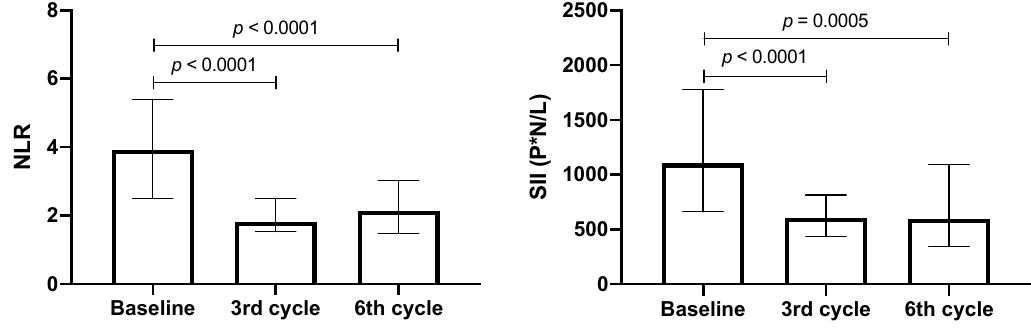
Figure 3. Concentration of IL-6, TGF- β , and HMGB-1 in patients with shorter (<12 months, n = 22) or longer (>12 months, n = 31) OS. Median and interquartile ranges are shown.